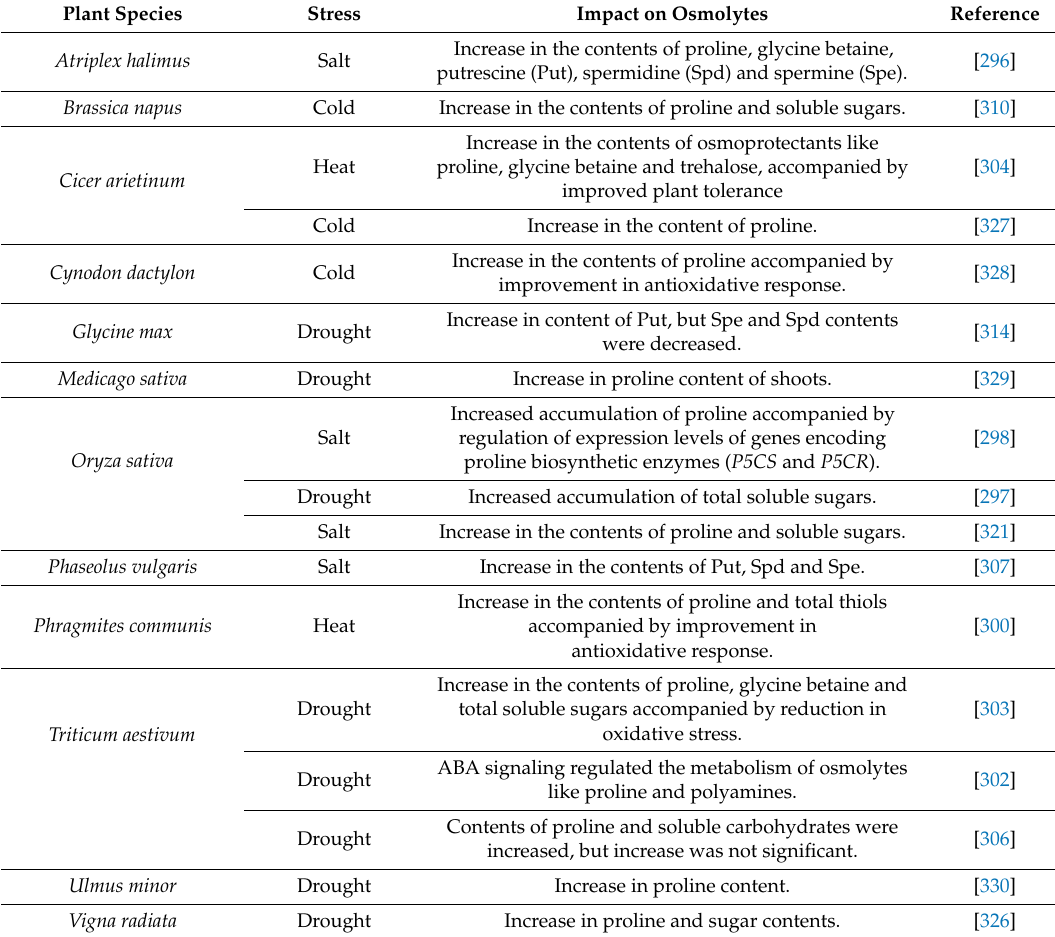
Table 2. Summary of the e ff ects of abscisic acid on osmolytes under various abiotic stresses. Plant Species Stress Impact on